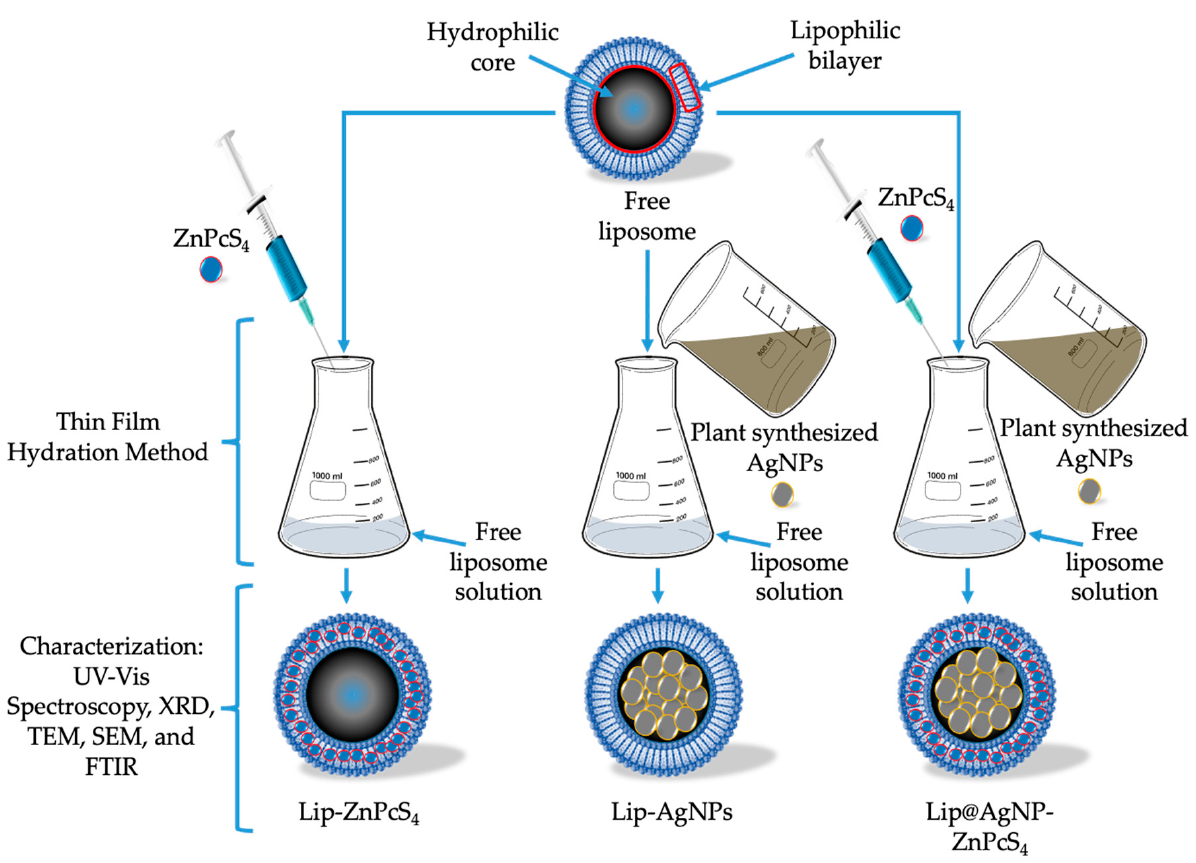
Figure 4. Schematic diagram representing green synthesis of Lip-ZnPcS 4 and characterization techniques.